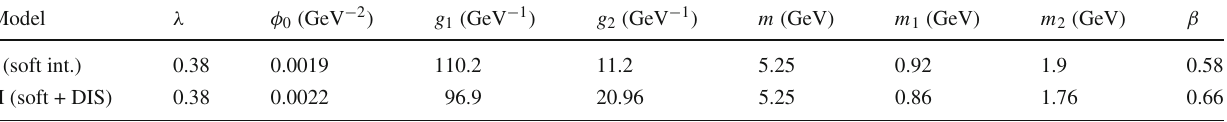
Table 1 Fitted parameters of the model. Fit I: parameters for the soft interaction at high energy are taken from Ref. [40]. The additional parameters for DIS were found by fitting to the F 2 structure function